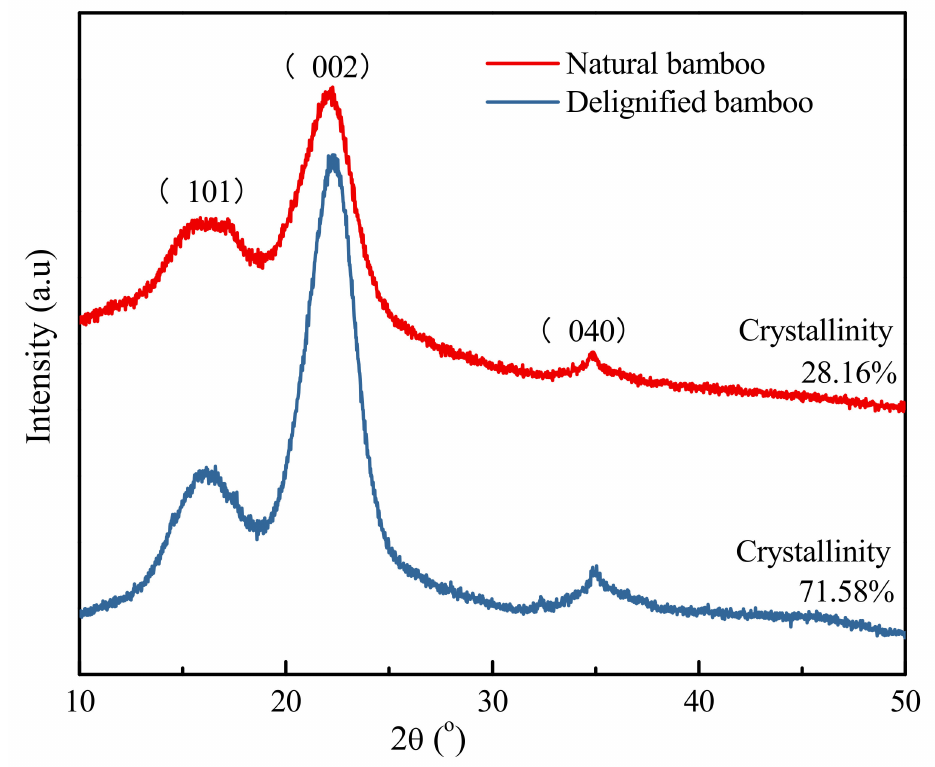
Figure 4. X-ray diffraction (XRD) patterns of NB and